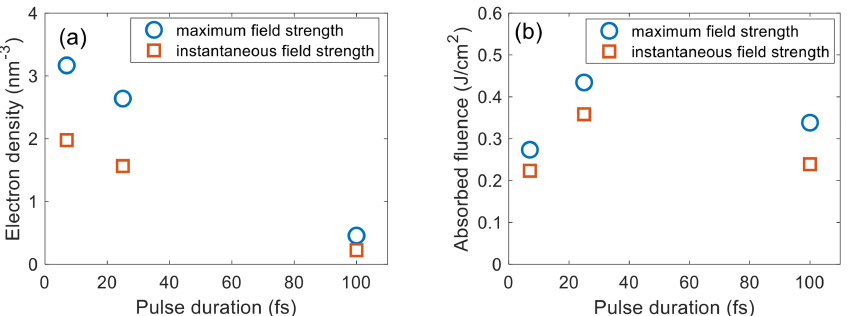
Figure 12. Comparison of ( a ) electron density and ( b ) absorbed fluence in fused silica calculated from the Keldysh photoionization rates using the instantaneous electric field strength vs. the maximum field strength in an optical cycle, respectively. The pulse parameters are the same as those in Figure